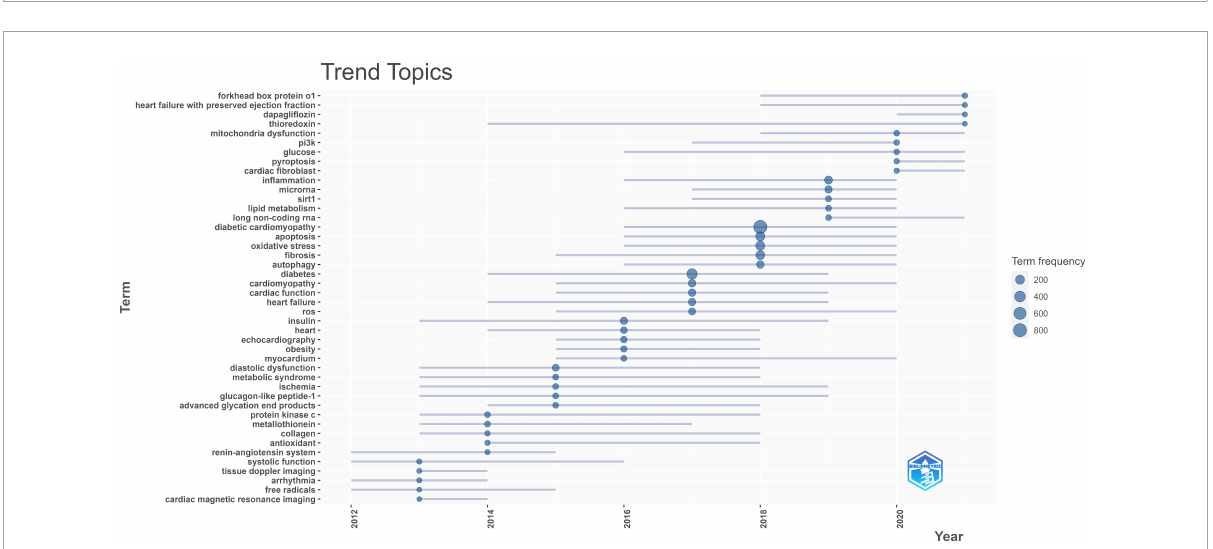
inhibitors showing promising benefits on DM